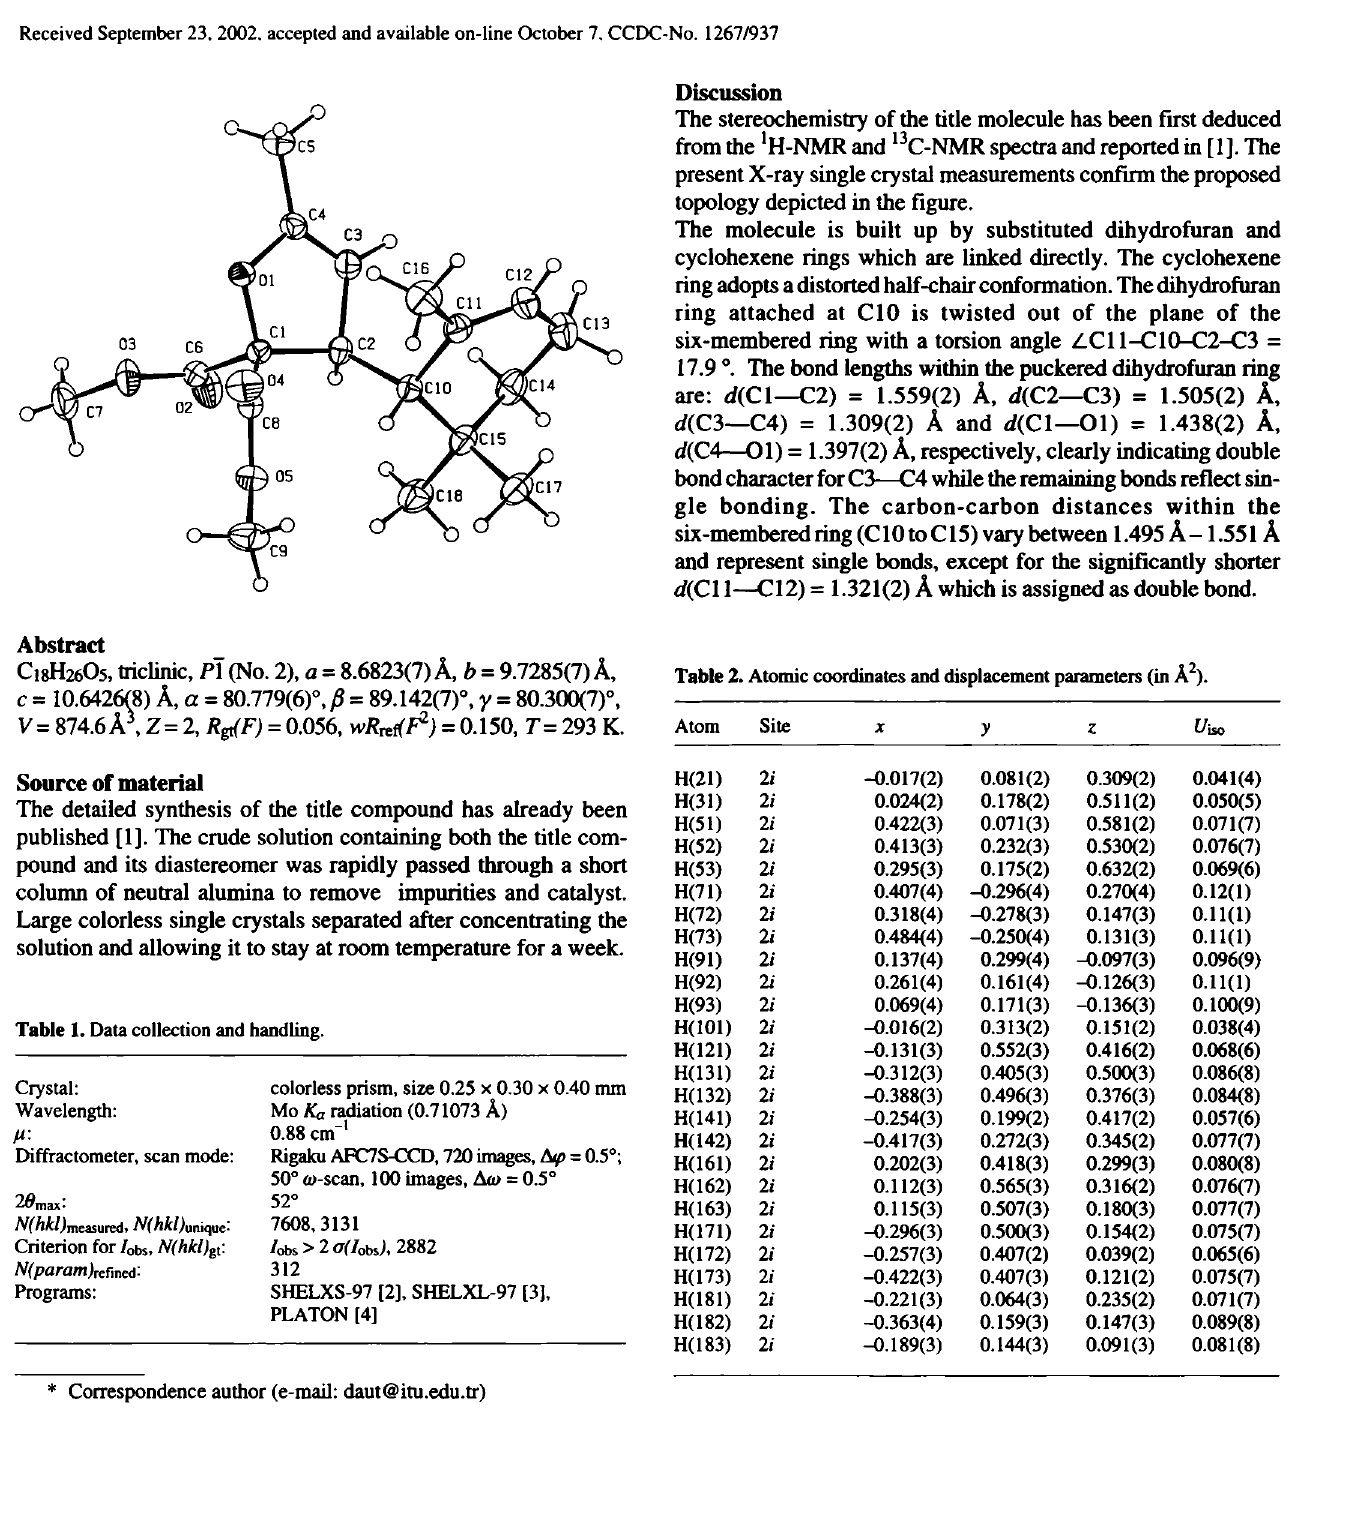
Table 1. Data collection and handling.